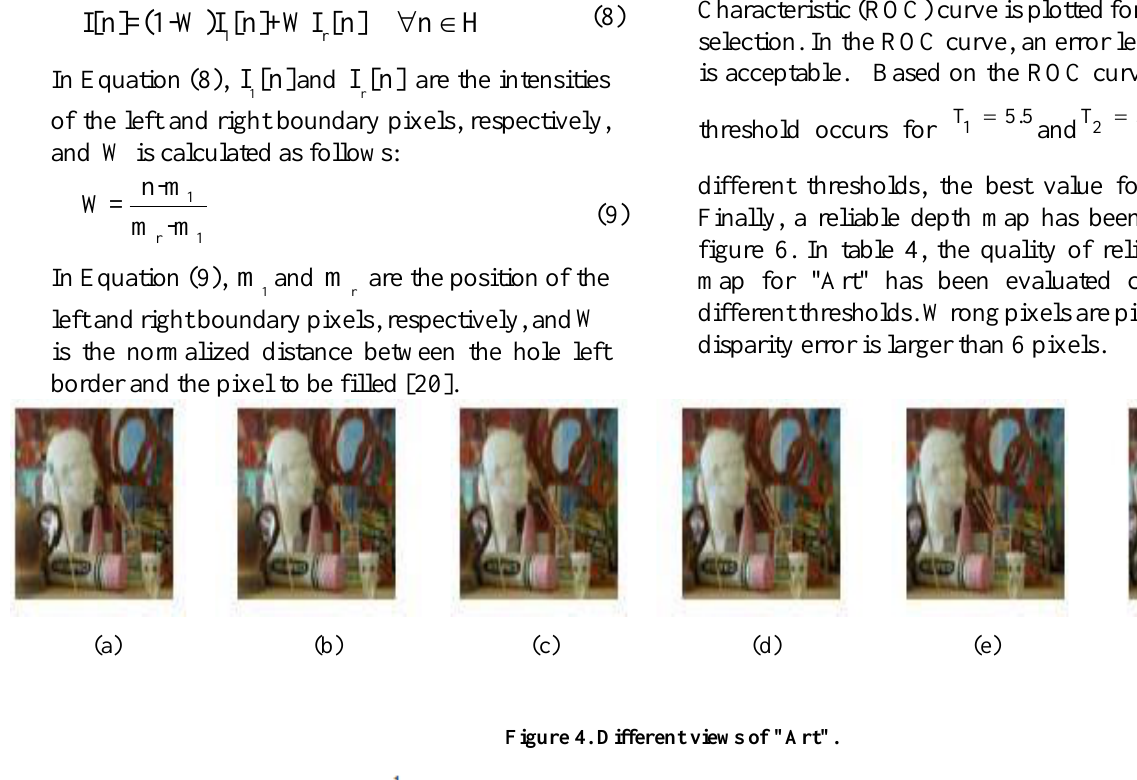
Figure 4. Different views of "Art".